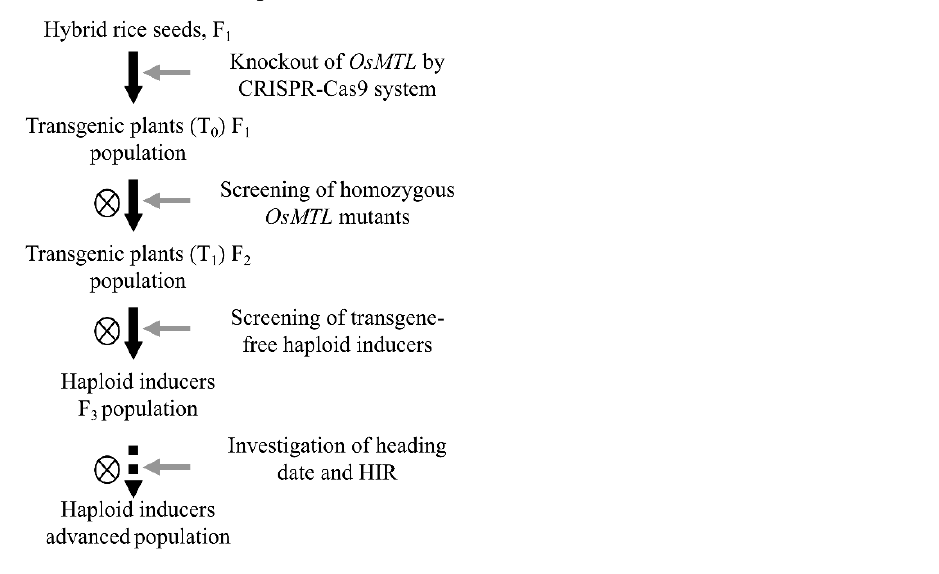
Figure 1. Flow chart of the method used to develop multiple-heading-date mtl haploid inducer lines in rice.